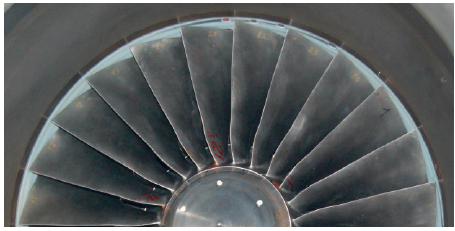
Figure 25. Single reference fan (SRF) model.